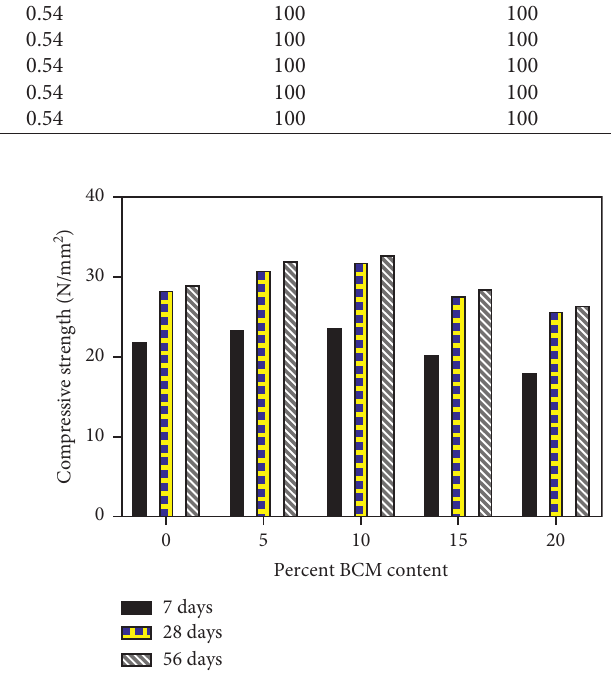
Figure 3: Compressive strength of concrete.